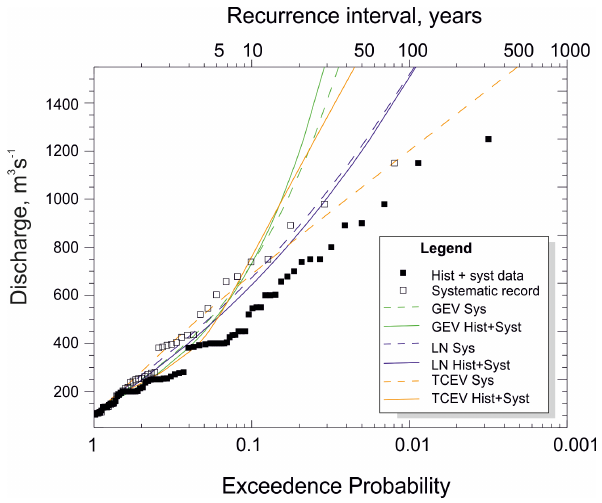
Figure 5. Log-normal (LN), Generalised extreme value (GEV) and two-component extreme-value (TCEV) distributions fitted with (1) systematic data and (2) systematic and historical flood data. Dots represent the plotting positions for the systematic record (white dots) and historical plus systematic records (black dots).